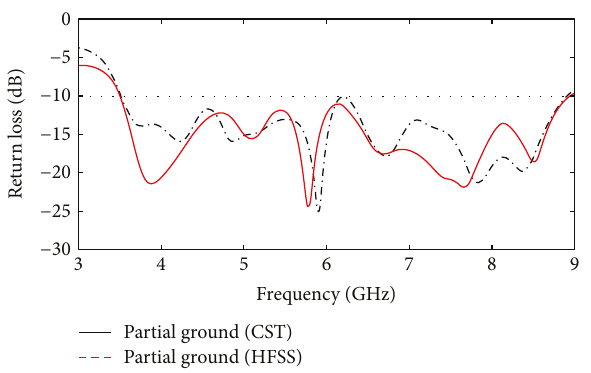
Figure 8: Return loss comparison between HFSS and CST for the array antennas with partial ground plane.